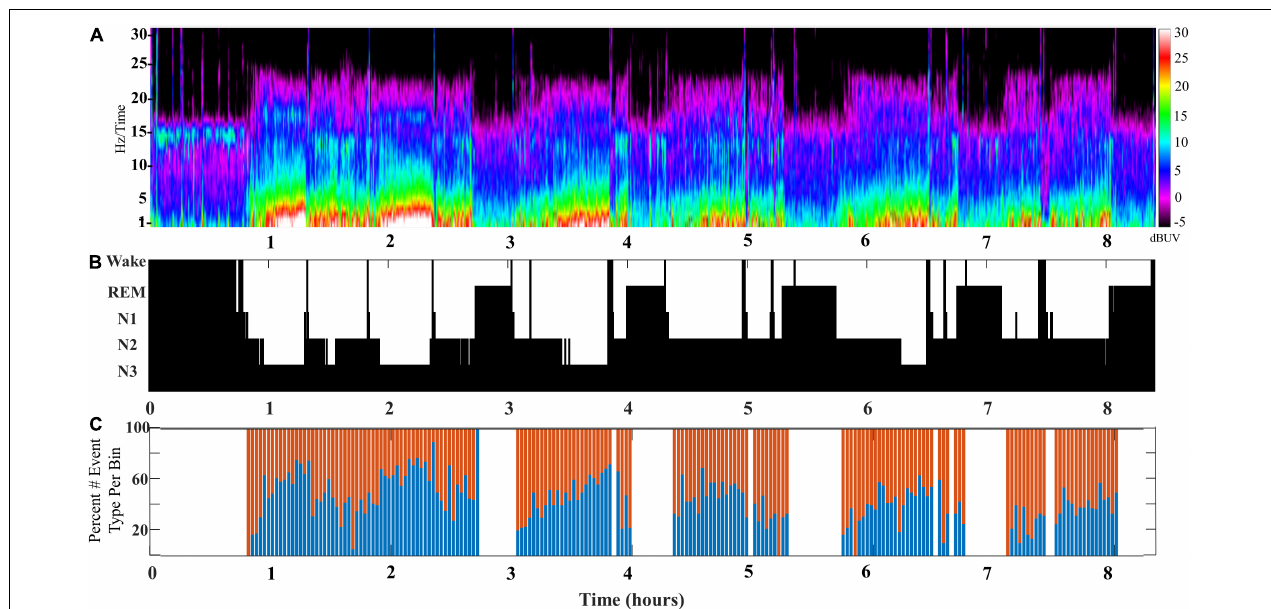
FIGURE 3 | (A) An illustrative example of SWA composition for a single participant aged 24 years old (DREAMS Subject 3). A color density spectral array provides a graphic illustration of EEG power for an entire overnight sleep recording of a single subject. (B) The hypnogram marking sleep stages for this subject’s overnight sleep recording is illustrated. (C) The percentage of early-fast spindle/slow waves (red bars) and late-fast spindle/slow waves (blue bars) in each time bin of 2 min is graphed to illustrate the composite mix of SWA across a single night of sleep.